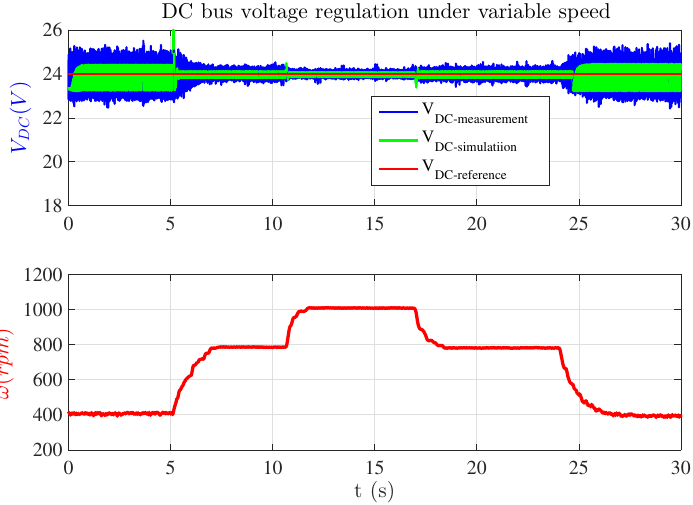
Figure 14. SRG operation under variable speed, at R L = 15 Ω